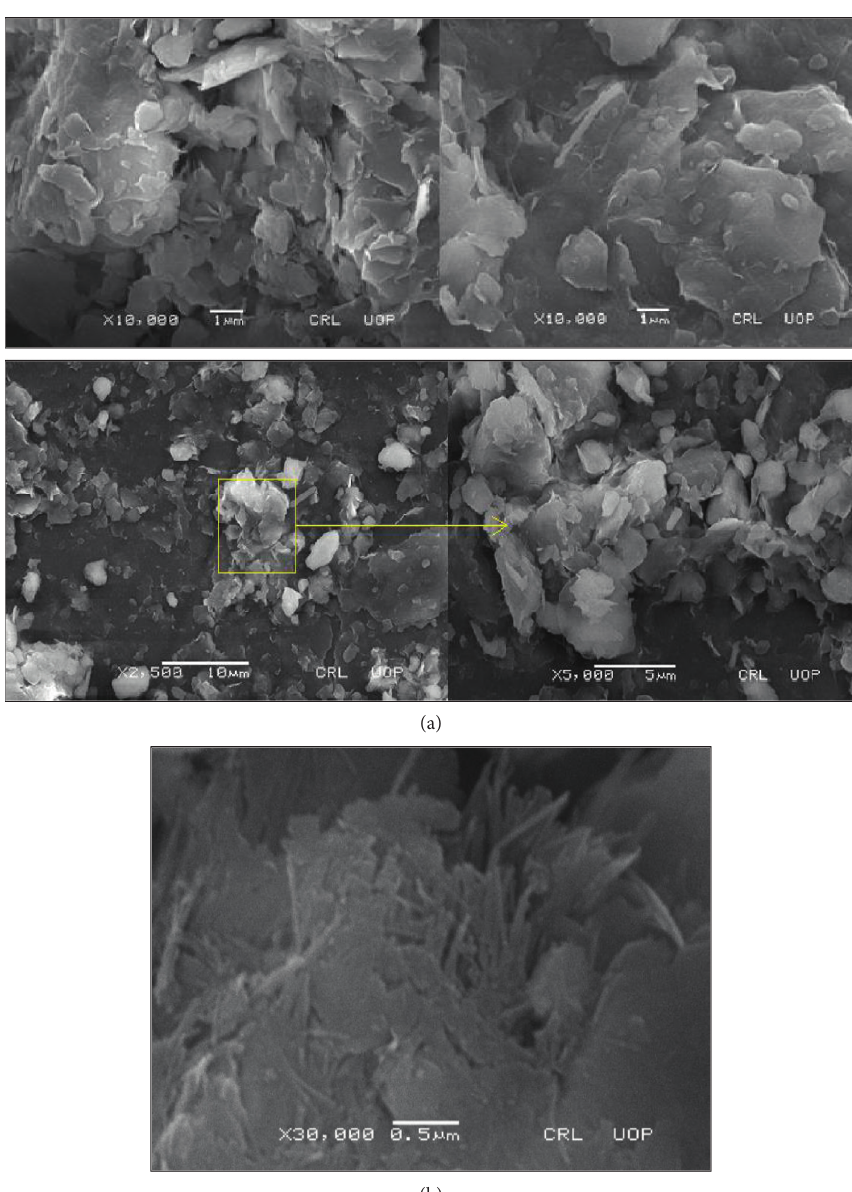
Figure 8: (a) SEM images of expansive soil at a different magnification level. (b) SEM image showing the fiber-like structure of